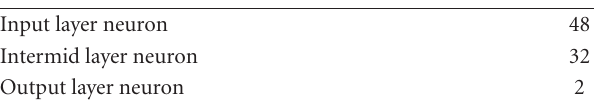
Table 2: Construction of NNs for classification and recognition parts.